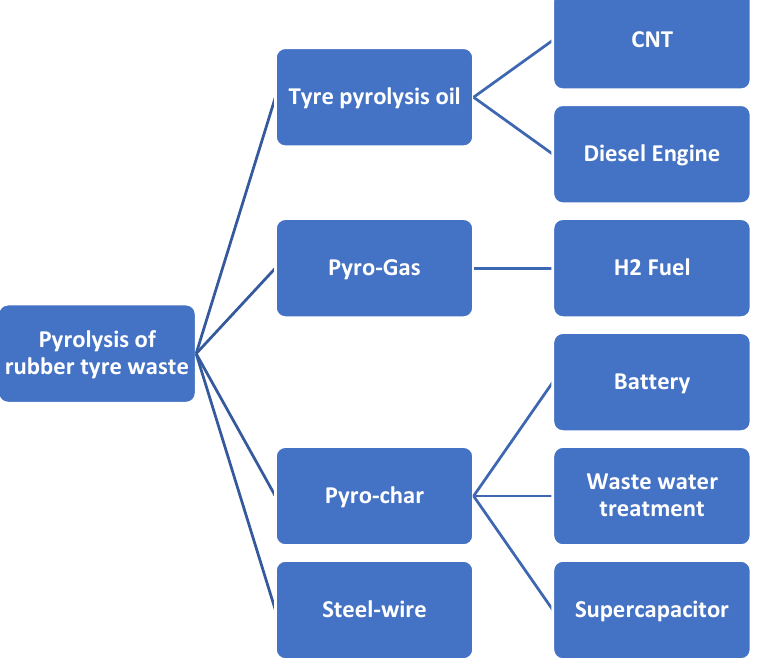
Figure 4. Waste tyre pyrolysis products and their applications.